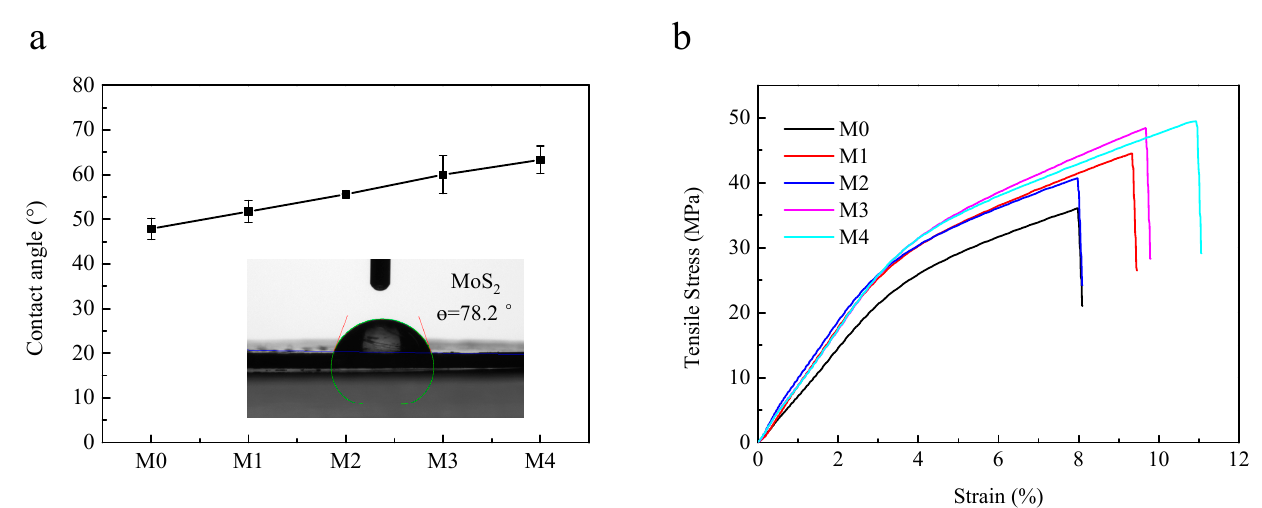
9 of 15 Figure 6. XRD patterns of PES membrane and PES/MoS 2 membranes. To investigate the effect of the MoS 2 concentration on the hydrophilicity of membrane